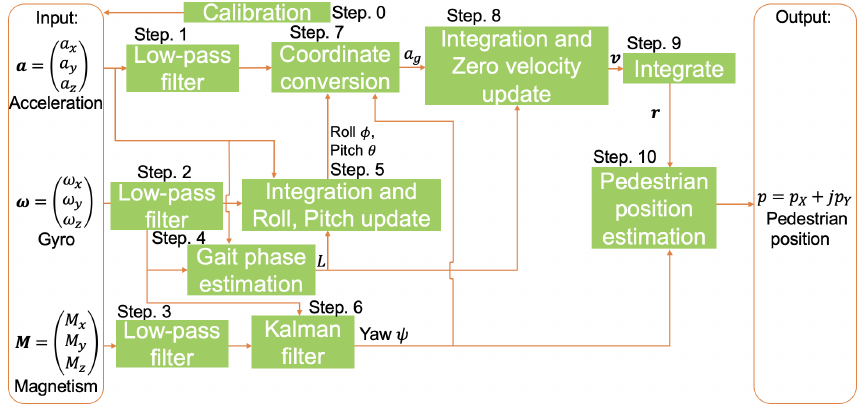
Figure 2. System